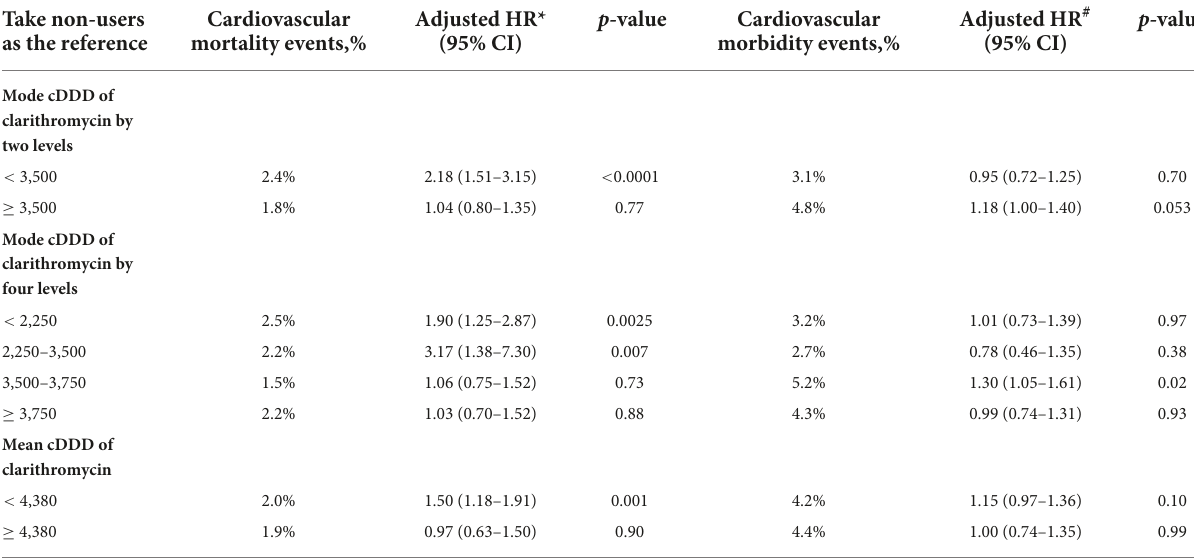
TABLE 4 Association of several approaches to cumulative define daily dose (cDDD) of clarithromycin with cardiovascular outcomes. Take non-users as the reference